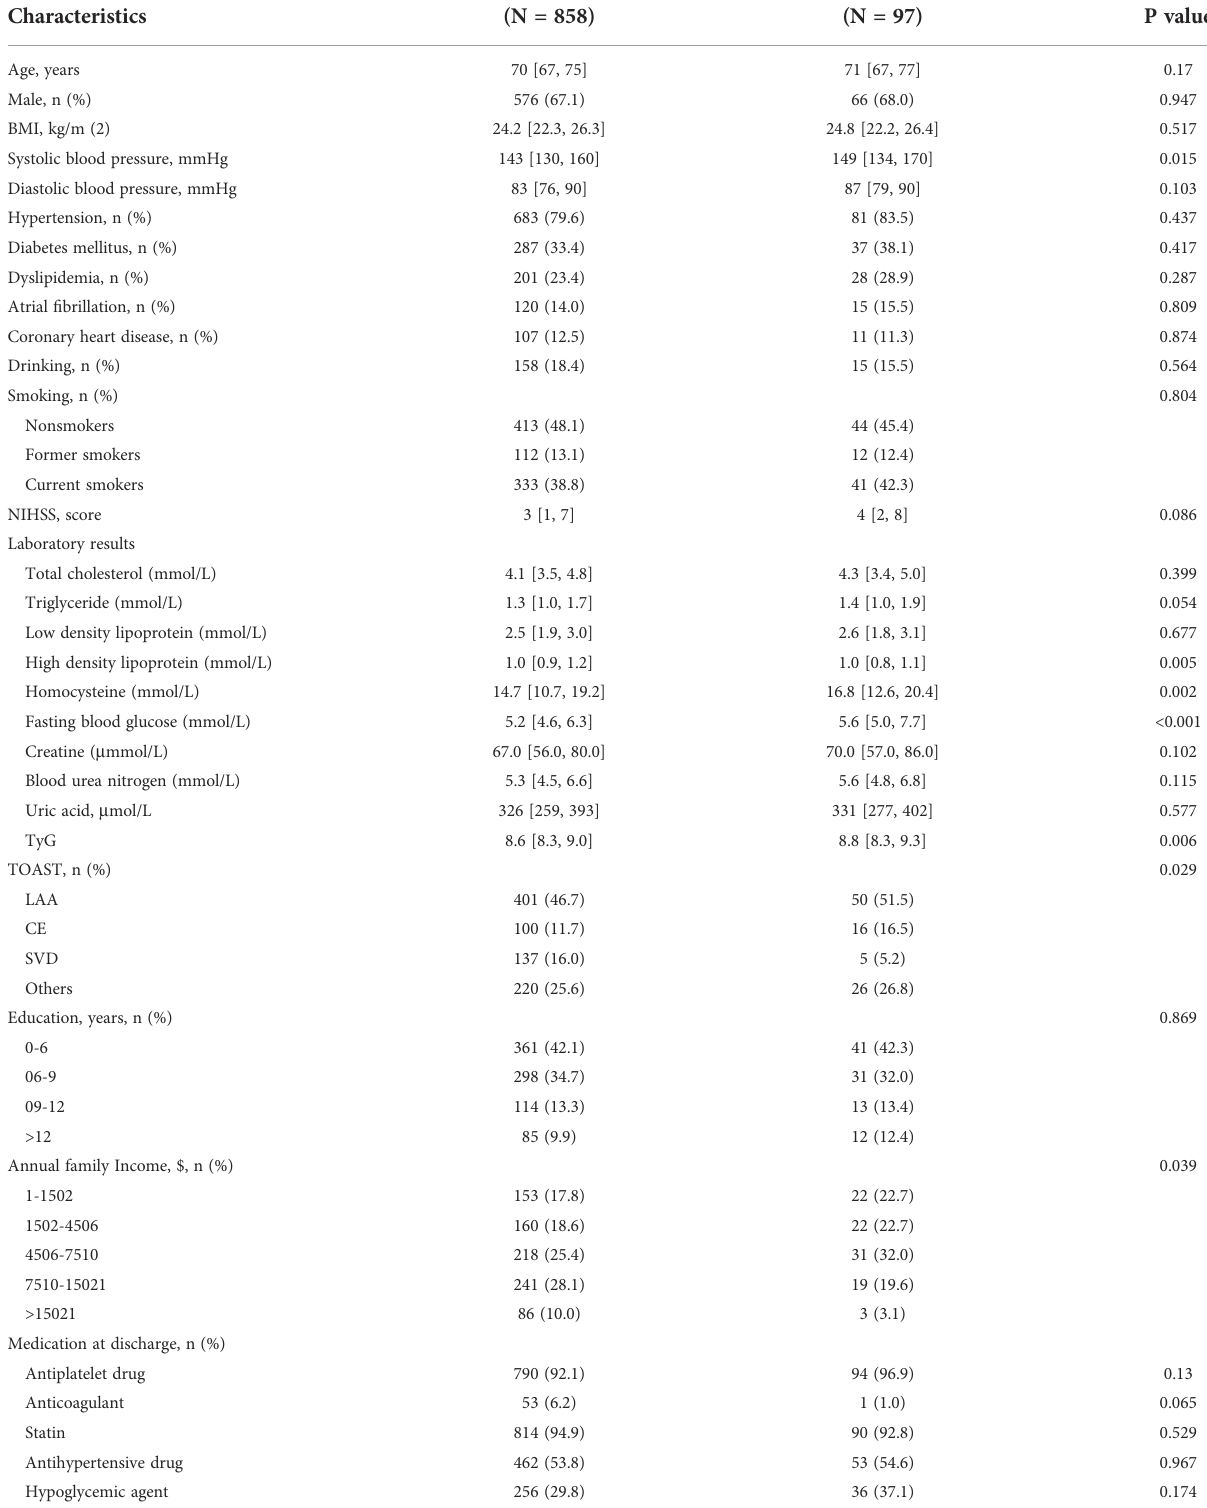
TABLE 1 Baseline Characteristics between Patients with or without Stroke Recurrence in the